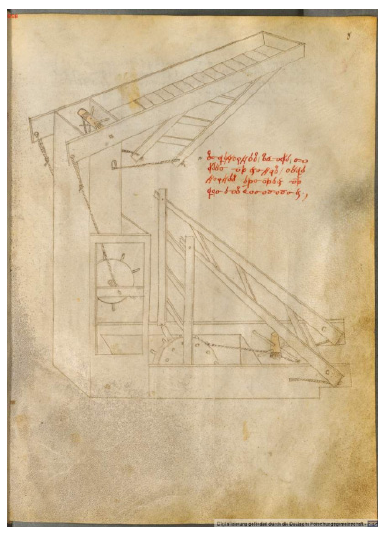
Figure 4.A siege machine with a linked boom [22].